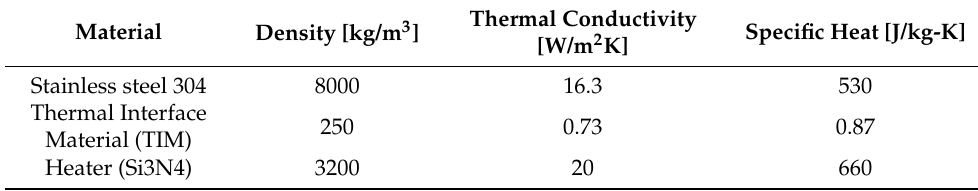
Table 1. The thermal properties of the CAHP.